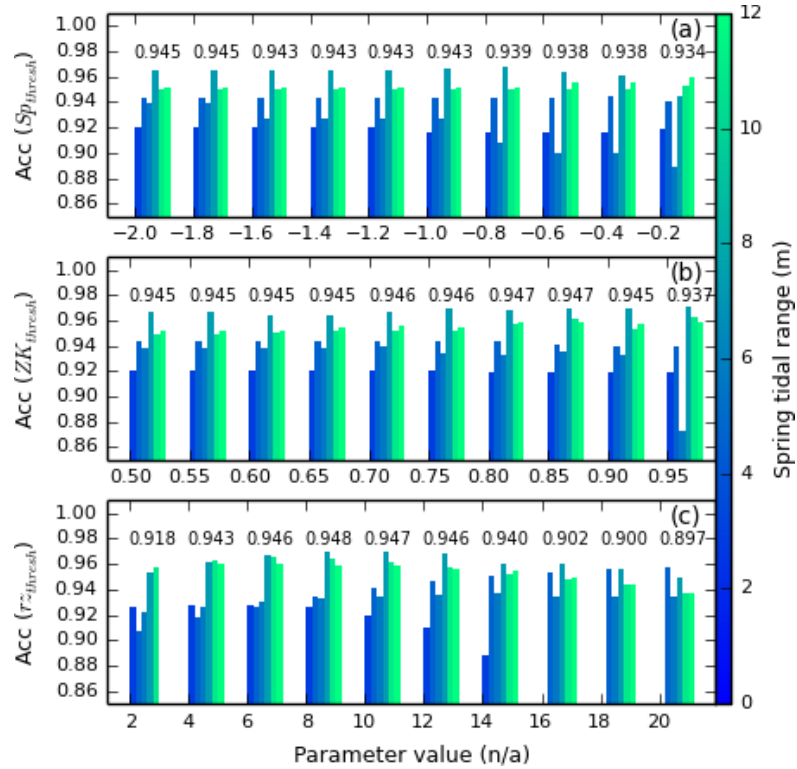
Figure 7. Accuracy charts used to optimise the three user-defined parameters for the six test sites, each site being coloured by spring tidal range, with no filter. Each group of bars represents the accuracy for one parameter value when applied to all the test sites. The mean accuracy appears above each group. (a) Accuracy for the parameter Opt1; the retained value for Opt1 is − 2.0. (b) Accuracy for the parameter Opt2; the retained value for Opt2 is 0.85. (c) Accuracy for the parameter Opt3; the retained value for Opt3 is